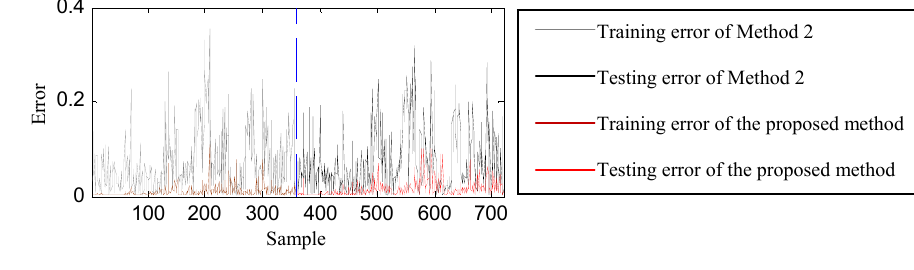
Figure 7. Classification errors of Method 2 and the proposed method.